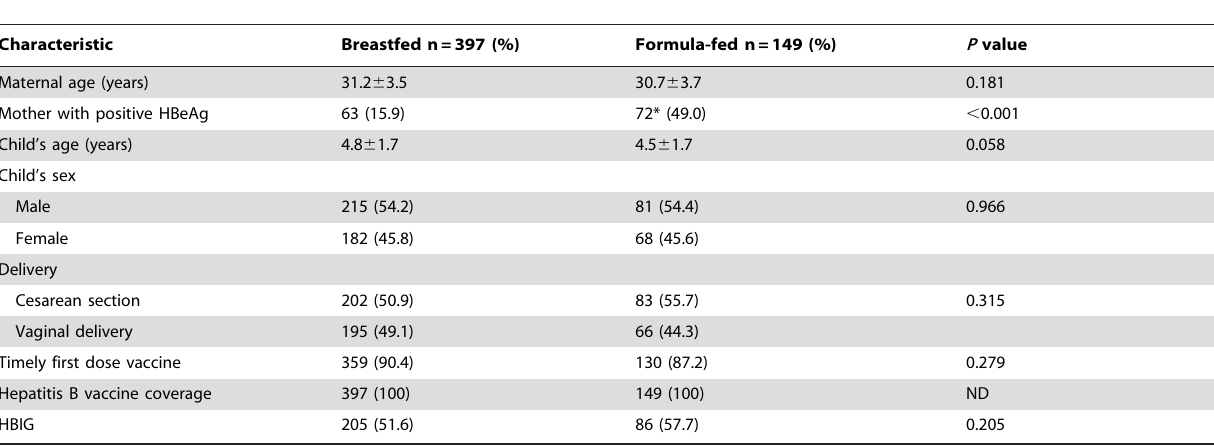
Table 1. General characteristic of children and their mothers in breast- and formula-fed groups.